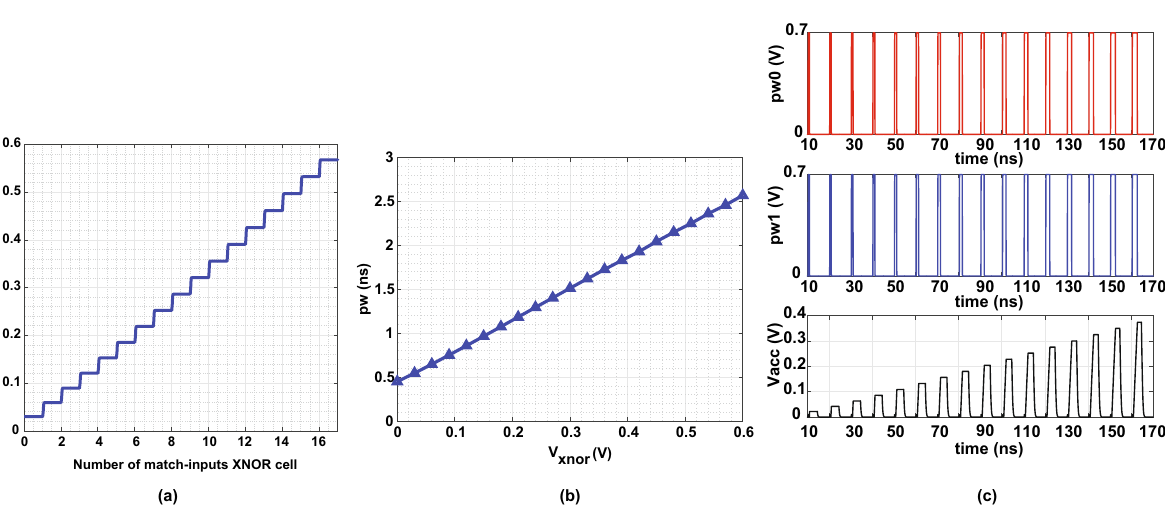
Figure 4. ( a ) Similarity output voltage V xnor versus the number of matching inputs for 16-bit XNOR-based RRAM at V dd =0.6 V. ( b ) Modulated pulse width signal pw scales linearly with the similarity output voltage V xnor at V dd − add =0.7 V. ( c ) Modulated pulse width signals pw 0 nd pw 1 are converted to V acc via TVC for a 32-bit XNOR-based RRAM divided into two 16-bit XNOR blocks. Each pulse width corresponds to number of matching-inputs XNOR cells. The minimum pulse width corresponds to all mismatching inputs and the maximum pulse width means 16 matching inputs XNOR